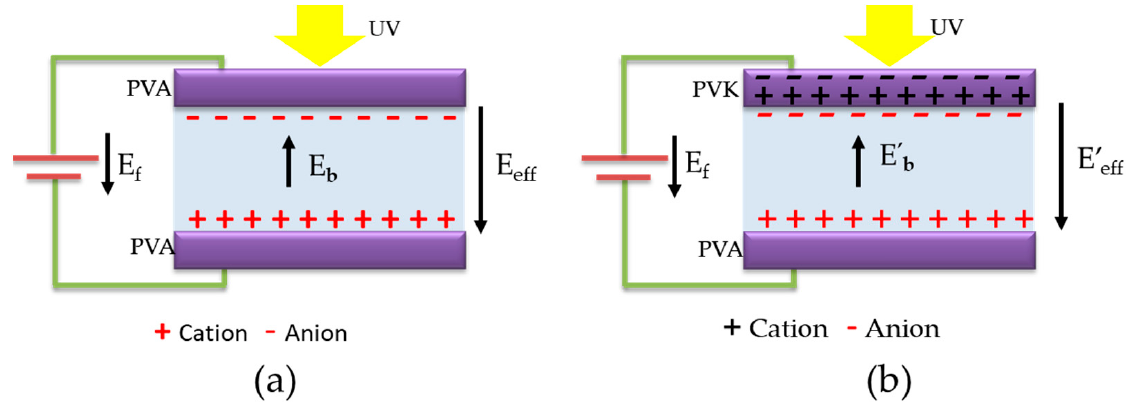
Figure 4. Diagram of the effective electric field in the CLC devices with different alignment layer under an external applied voltage. ( a ) PVA-PVA alignment layer; ( b ) PVA-PVK alignment layer.